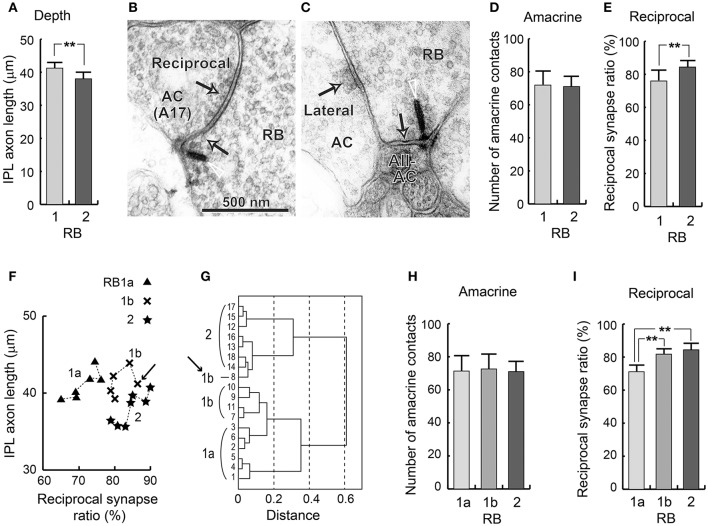
Groupings of RB cells. (A) The depth (IPL axon length) of RB cells as measured by the distance from the INL-IPL border to the axon terminal. (B) The electron micrograph of a ribbon synapse (arrowhead and arrow) from a RB cell axon terminal to an amacrine cell (possibly type A17), and a conventional synapse (arrow) reciprocally directed from an amacrine cell to the RB cell axon terminal. (C) The electron micrograph of a ribbon synapse (arrowhead and arrow) from the RB cell axon terminal to an AII amacrine cell (AII-AC), and a conventional synapse (arrow) laterally directed from another amacrine cell to the RB cell. (D) The total number of amacrine cell synapses directed to RB cells. (E) The percentage of ribbon synapses with reciprocal feedback from immediate amacrine cell dendrites. (F) A scatter plot of the two variables in (D,E) which shows significant differences among the three RB cell subtypes. (G) Clustering of the 18 RB cells using the two variables in (F). (H) The total number of amacrine cell synapses directed to RB cells. (I) The percentage of ribbon synapses with reciprocal feedback from immediate amacrine cell dendrites. **p < 0.01; unpaired two-tailed Student's t-test.